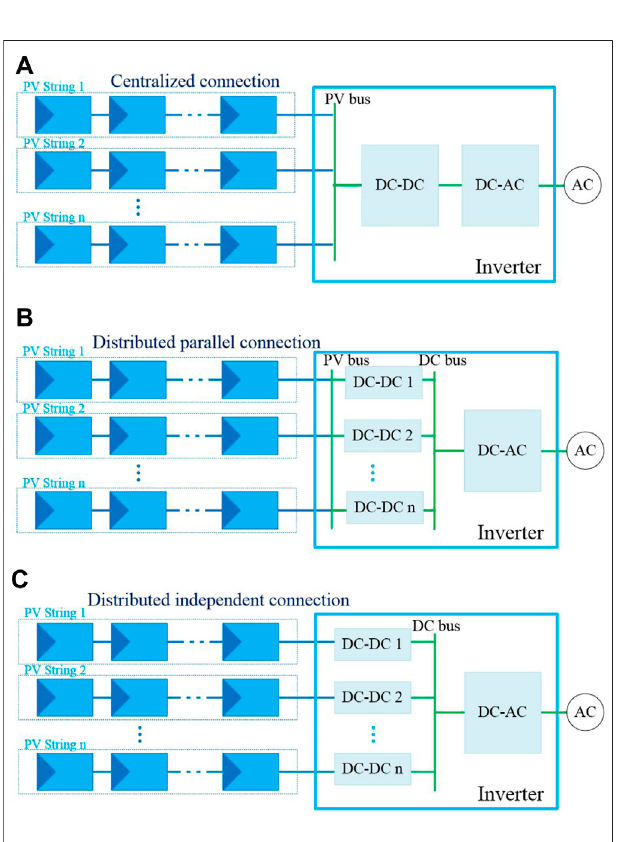
FIGURE 3 | PV string connection types: (A) central connection, (B) parallel connection, and (C) independent